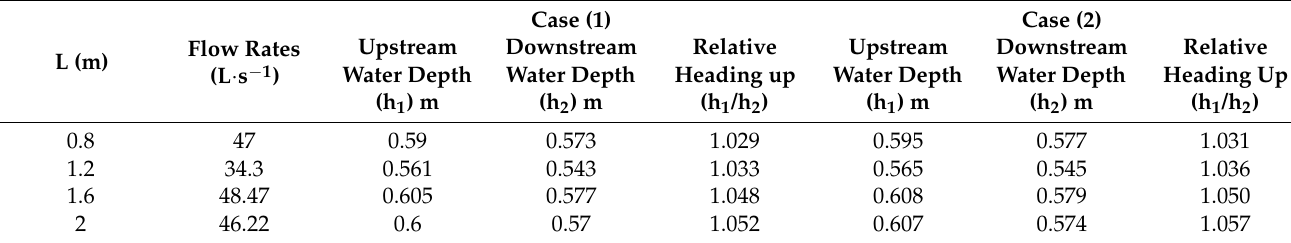
Figure 8. Sectional elevation in the canal where a biofilter was installed as continuous and fragmented in the flow direction. ( a ) Continuous biofilter, ( b ) Fragmented biofilter. Table 4. The measured water depths upstream and downstream of the biofilter and the resulting relative heading up (h 1 /h 2 ) for the continuous and fragmented biofilter.